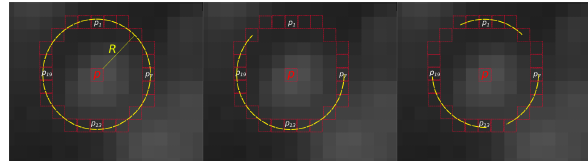
Matching by correlation